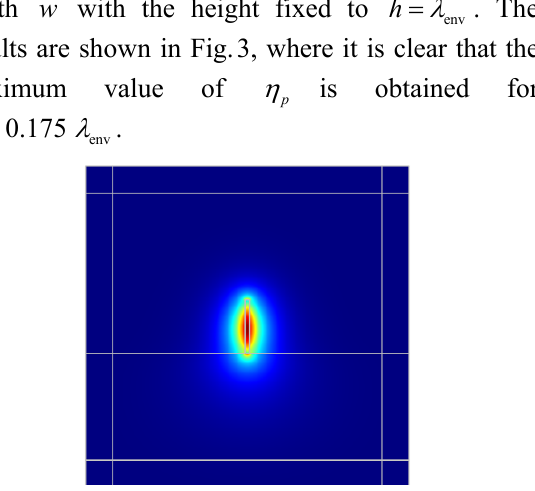
as function of the core p 0.175  w . env